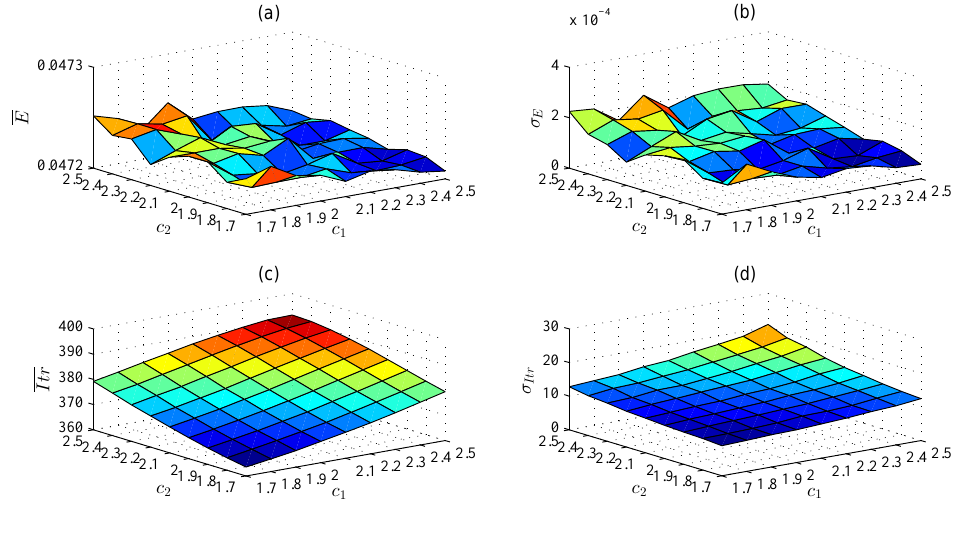
Figure 1. Localization performance of different c 1 and c 2 using WPSO with global-best model. ( a ) E ; ( b ) σ E ; ( c ) Itr ; ( d ) σ Itr